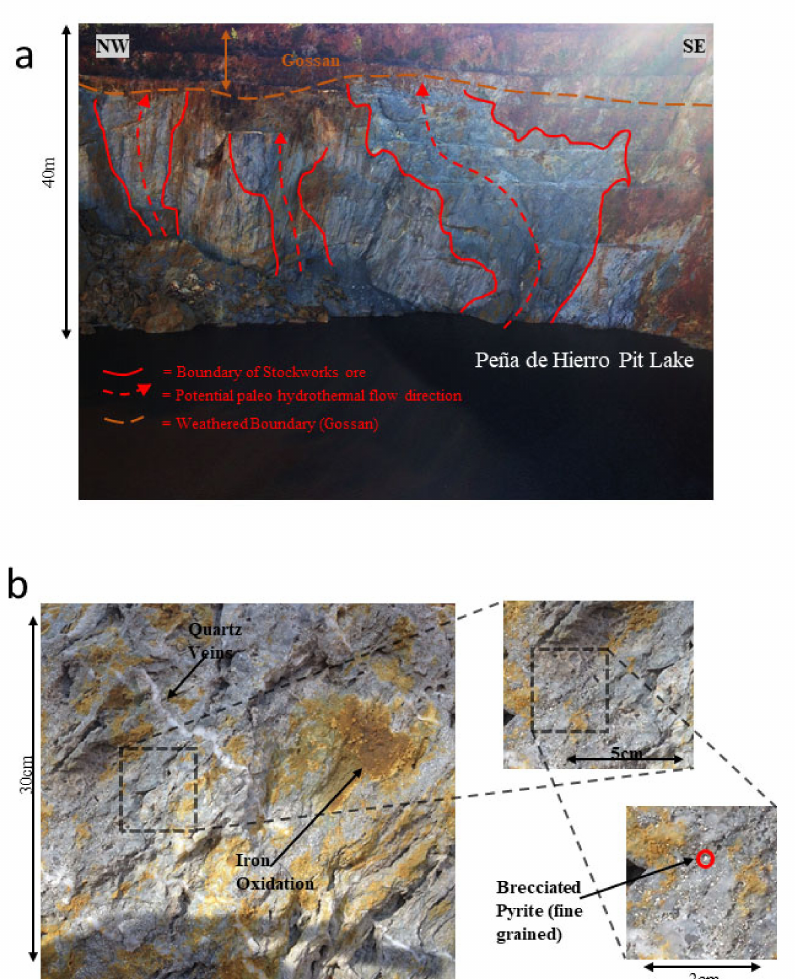
Figure 4. Main features of the stockwork orebody topped by gossan materials at the Peña de Hierro location, which is the source of the acidic springs feeding the Rio Tinto headwaters. ( a ) Carboniferous stockwork orebody showing the structure and lithology of hydrothermal origin. ( b ) Detail of the stockwork rocks composed of quartz and pyrite with clear evidence of weathering and